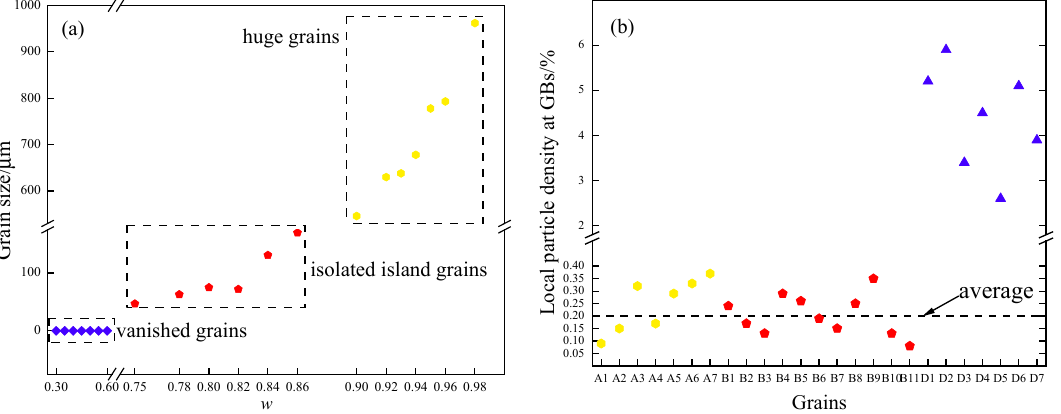
Figure 16. Quantitative analysis of the features of island grains at 140 min: ( a ) the relationship between ω and grain size; ( b ) local particle density at GBs, the blue triangles represent the local particle density at GB around serial island grains D1~D7.